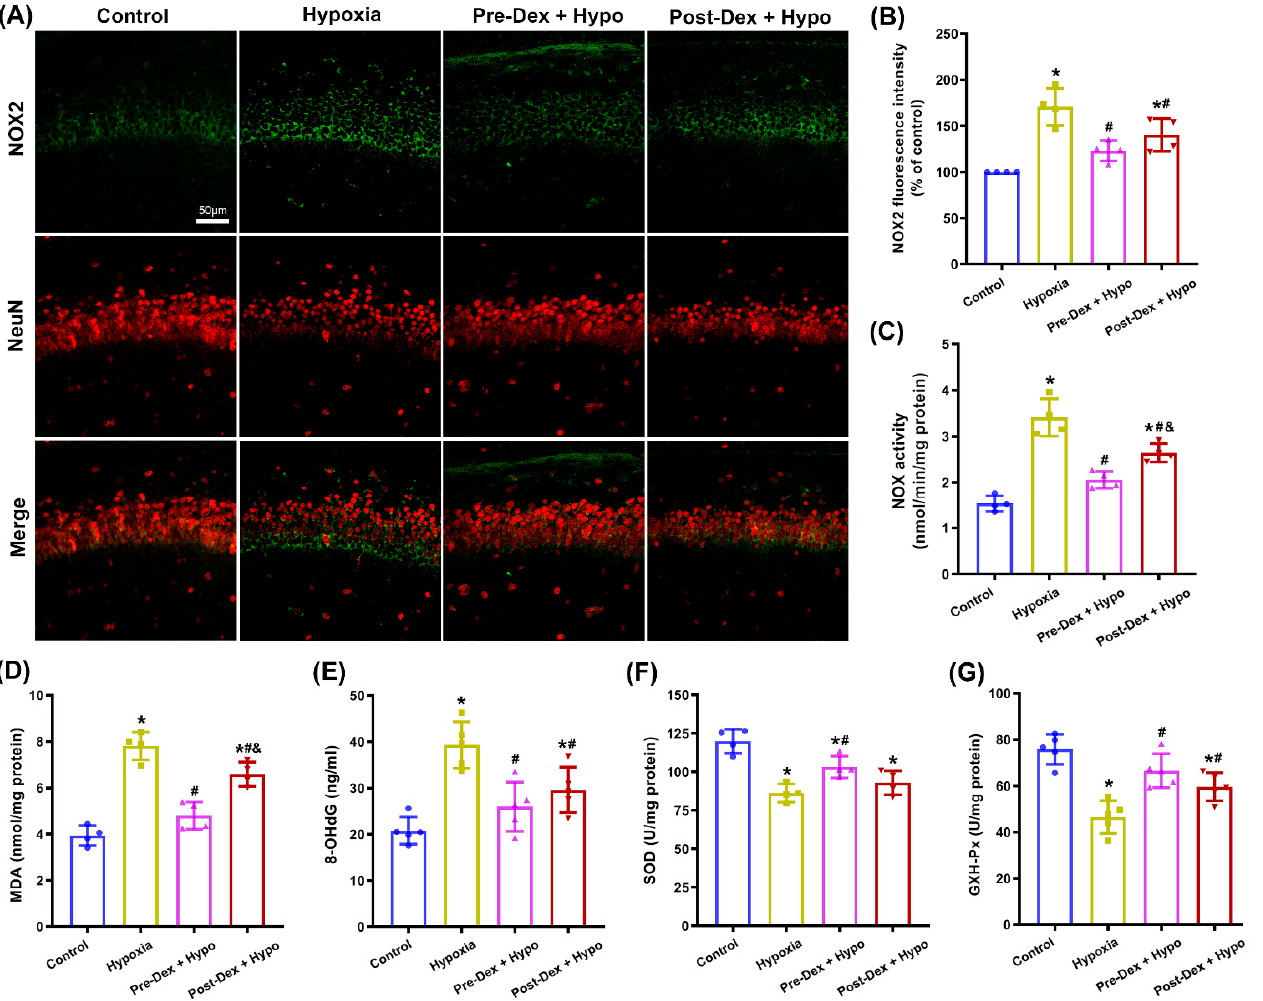
Figure 2. The effect of Dex on NOX2 activity and oxidative stress in the hippocampus following neonatal hypoxia. ( A ) Representative immunofluorescence images of NOX2 (green) and NeuN (red) in the hippocampal CA1 region. ( B ) The intensity of NOX2 fluorescence was quantified using Im- ageJ software. ( C ) A cytochrome c reduction assay was used to measure NOX activity. ( D ) MDA levels were assessed using the TBA colorimetric method. ( E ) DNA 8 − OHdG levels were determined using an 8 − OHdG ELISA kit. ( F ) SOD activity was assessed using the WST − 1 method. ( G ) GSH − Px activity was assessed using the UV colorimetric assay. Results are expressed as mean ± SD ( n = 4 − 5 in each group). Each animal data point in the bar graph is also presented. * p < 0.05 versus the Con- trol group; # p < 0.05 versus the Hypoxia group; & p < 0.05 versus the Pre-Dex group. Hypo, hypoxia; Pre-Dex, pretreatment with dexmedetomidine; Post-Dex, post-treatment with dexmedetomidine.